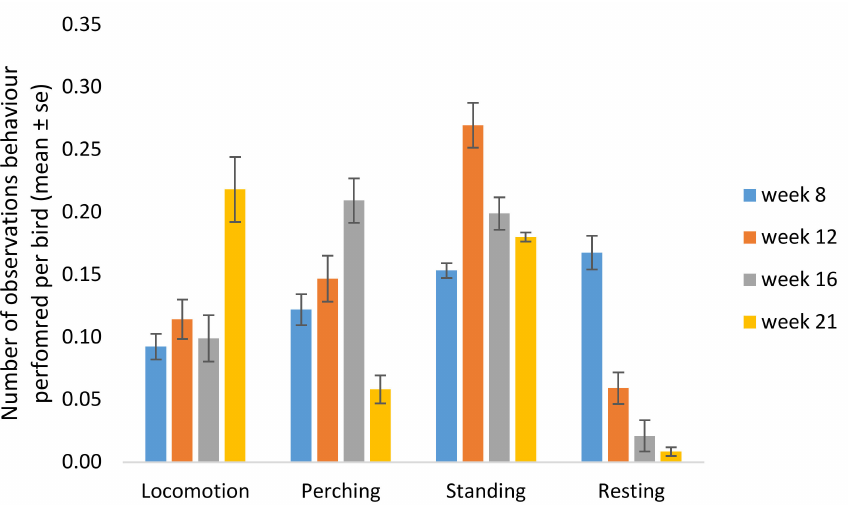
Figure 3. Number of instantaneous observations in which birds performed different behaviours at 8, 12, 16 and 21 weeks of age (mean of all light treatments).